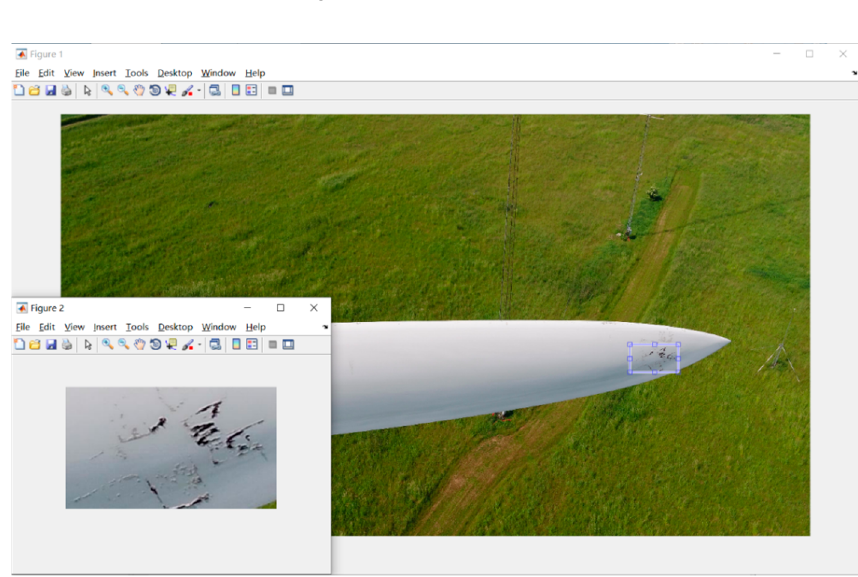
Figure 4. A region of interest for extraction.